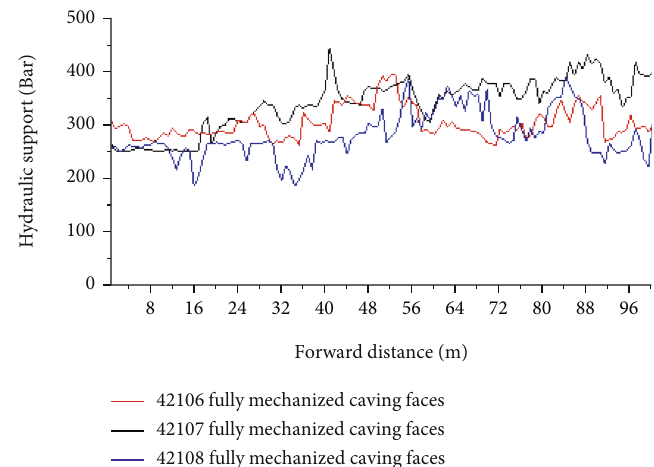
Figure 8: Comparison of average support load during initial production of fractured roof and unfractured working face.